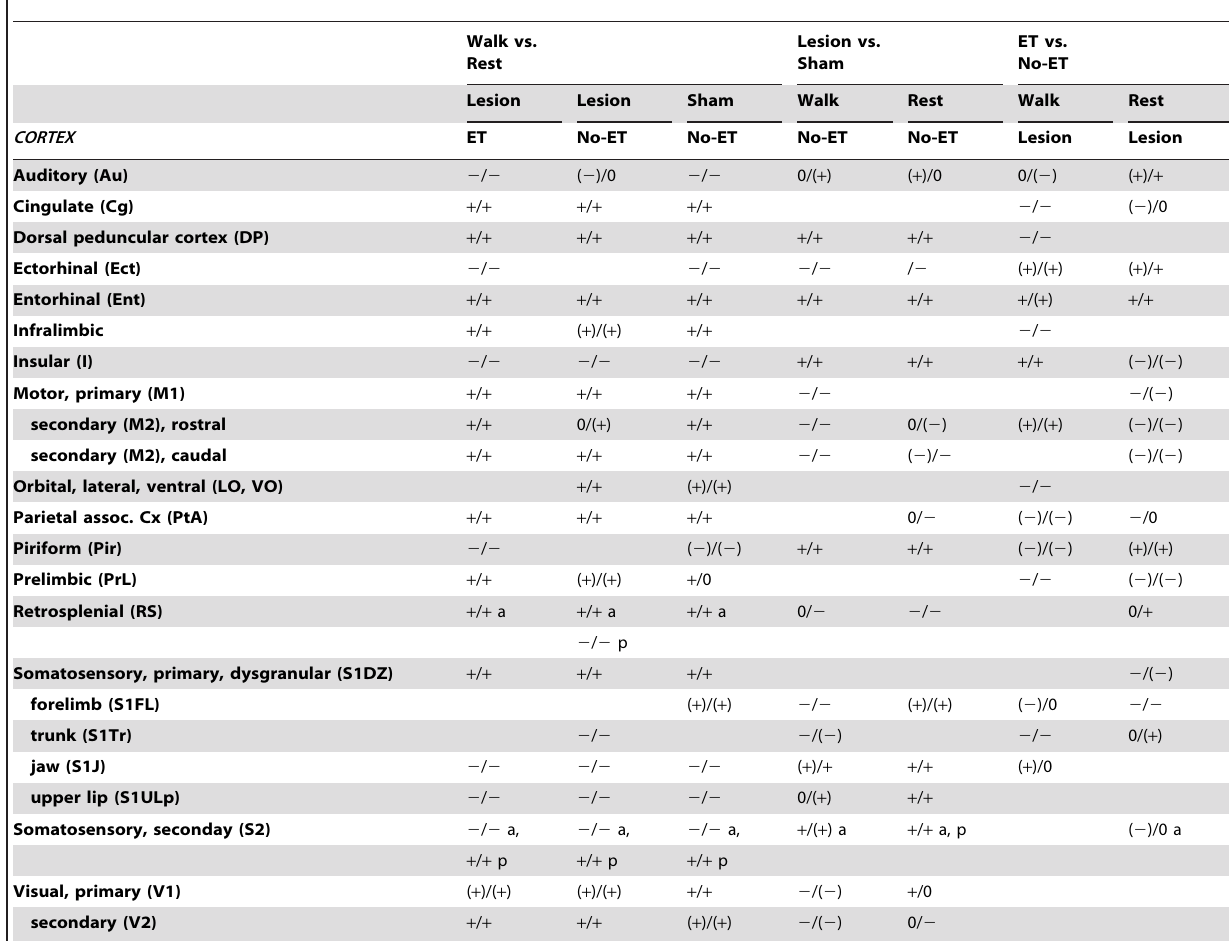
Table 1. Regions of statistically significant differences of functional cerebral cortical activation as determined by SPM analysis.